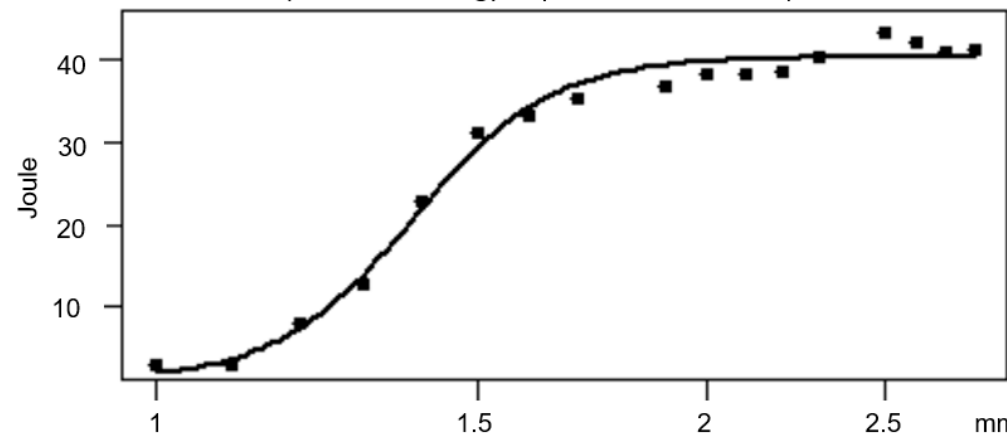
Figure 13. The relationship between energy consumption (Joule) for cutting plants of E. repens with various shoot diameters (mm) (5 W laser). Table 1. Estimated parameters and standard errors (SE) of the dose-response models (model 3) for experiments with a 5 W laser showing the relationship between energy consumption (Joule) for cutting plants E. repens with various shoot diameters (mm) corresponding to the curve in Figure 13. The parameter ED 50 is the effective dose (energy in Joule) required reducing the biomass by 50% between D and C. The parameter b is proportional to the slope at dose x equal to the parameter ED 50 . Laser Type